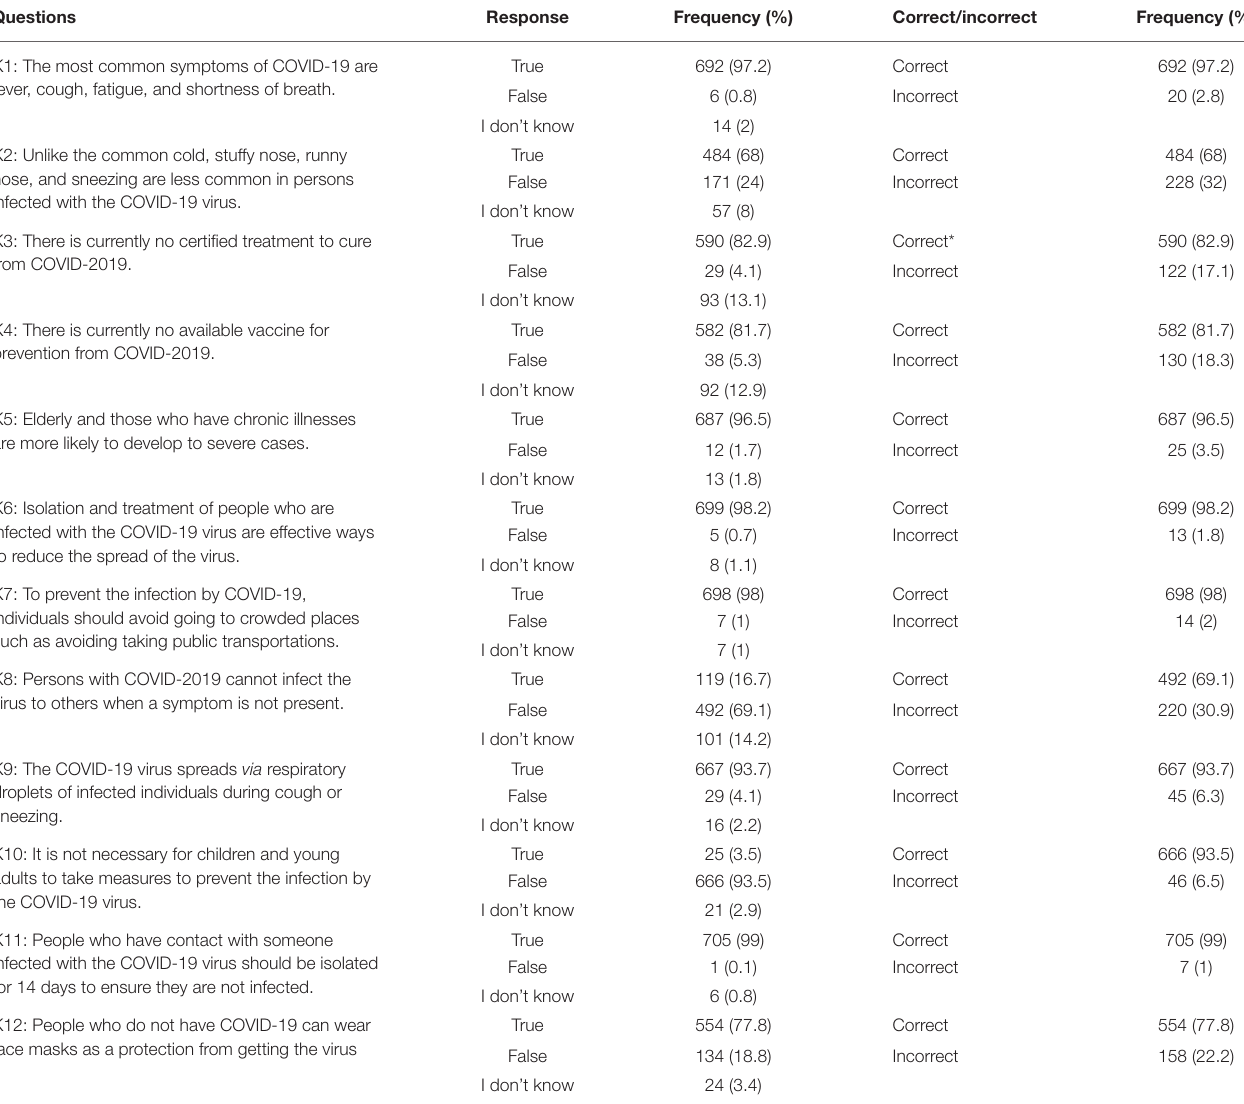
Table 3 | Respondents’ level of knowledge about COVID-19 ( N =